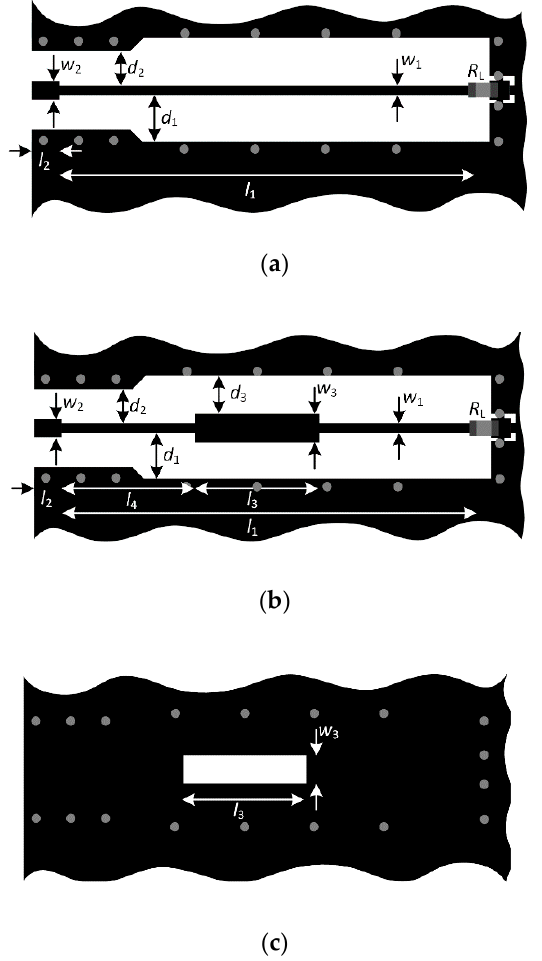
Figure 2. Loaded 50 Ω microstrip: without discontinuity and a solid reference plane on L2 ( a ); with discontinuity ( b ) and reference plane cutout on L2 ( c ).